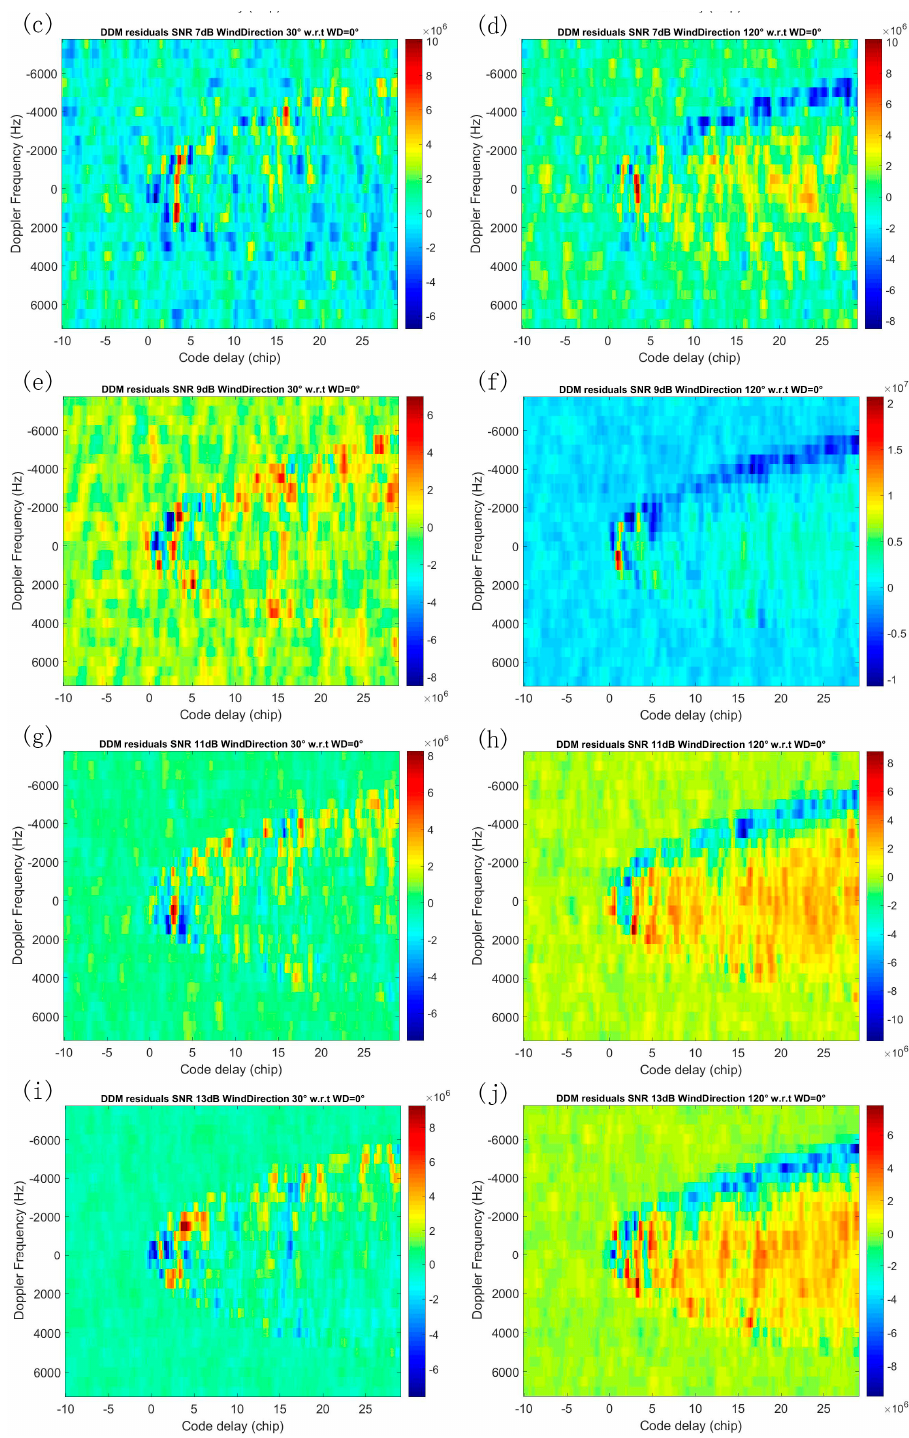
Figure 9. Noise DDM residuals with regard to DDM of wind direction 0°. The first column is DDM residuals of wind direction 30°, and the second column is DDM residuals of wind direction of 120°. From top to bottom, the SNR of each row is 5 dB, 7 dB, 9 dB, 11 dB, and 13 dB. ( a ) 30°, 5 dB; ( b ) 120°, 5 dB; ( c ) 30°, 7 dB; ( d ) 120°, 7 dB; ( e ) 30°, 9 dB; ( f ) 120°, 9 dB; ( g ) 30°, 11 dB; ( h ) 120°, 11 dB; ( i ) 30°, 13 dB; ( j ) 120°, 13 dB. The wind speed, elevation and azimuth of the receiver are 10 m/s, 60°, and 30°.